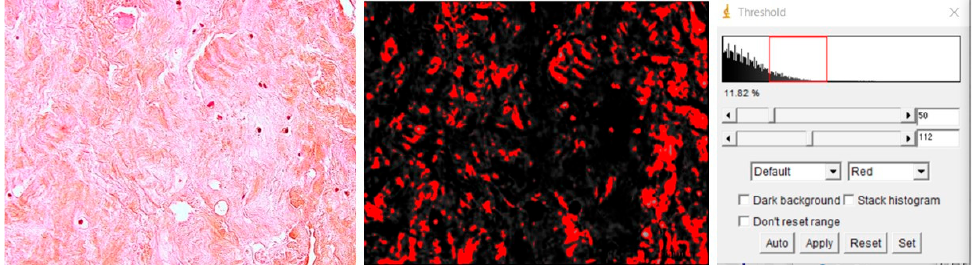
Figure 7. Quantitative evaluation of immunostaining using ImageJ. The percentage of regions stained red as positive regions for AGEs and RAGE staining was calculated.